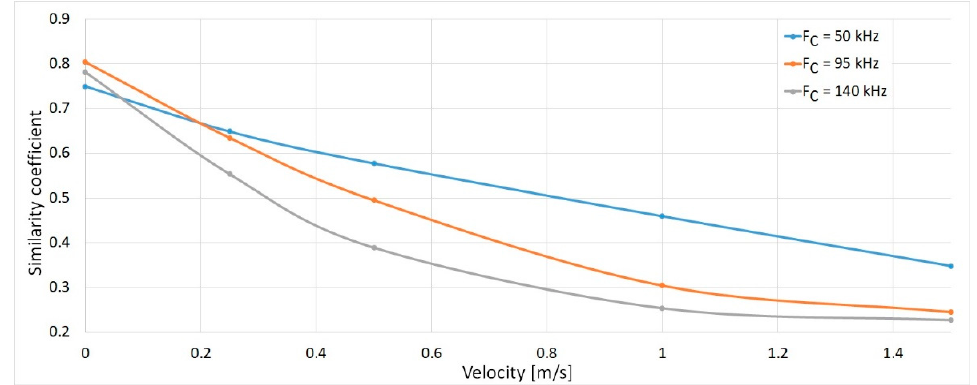
Figure 7. Similarity coefficients as a function of the transmitter velocity for the band 𝐵 = 20 kHz and